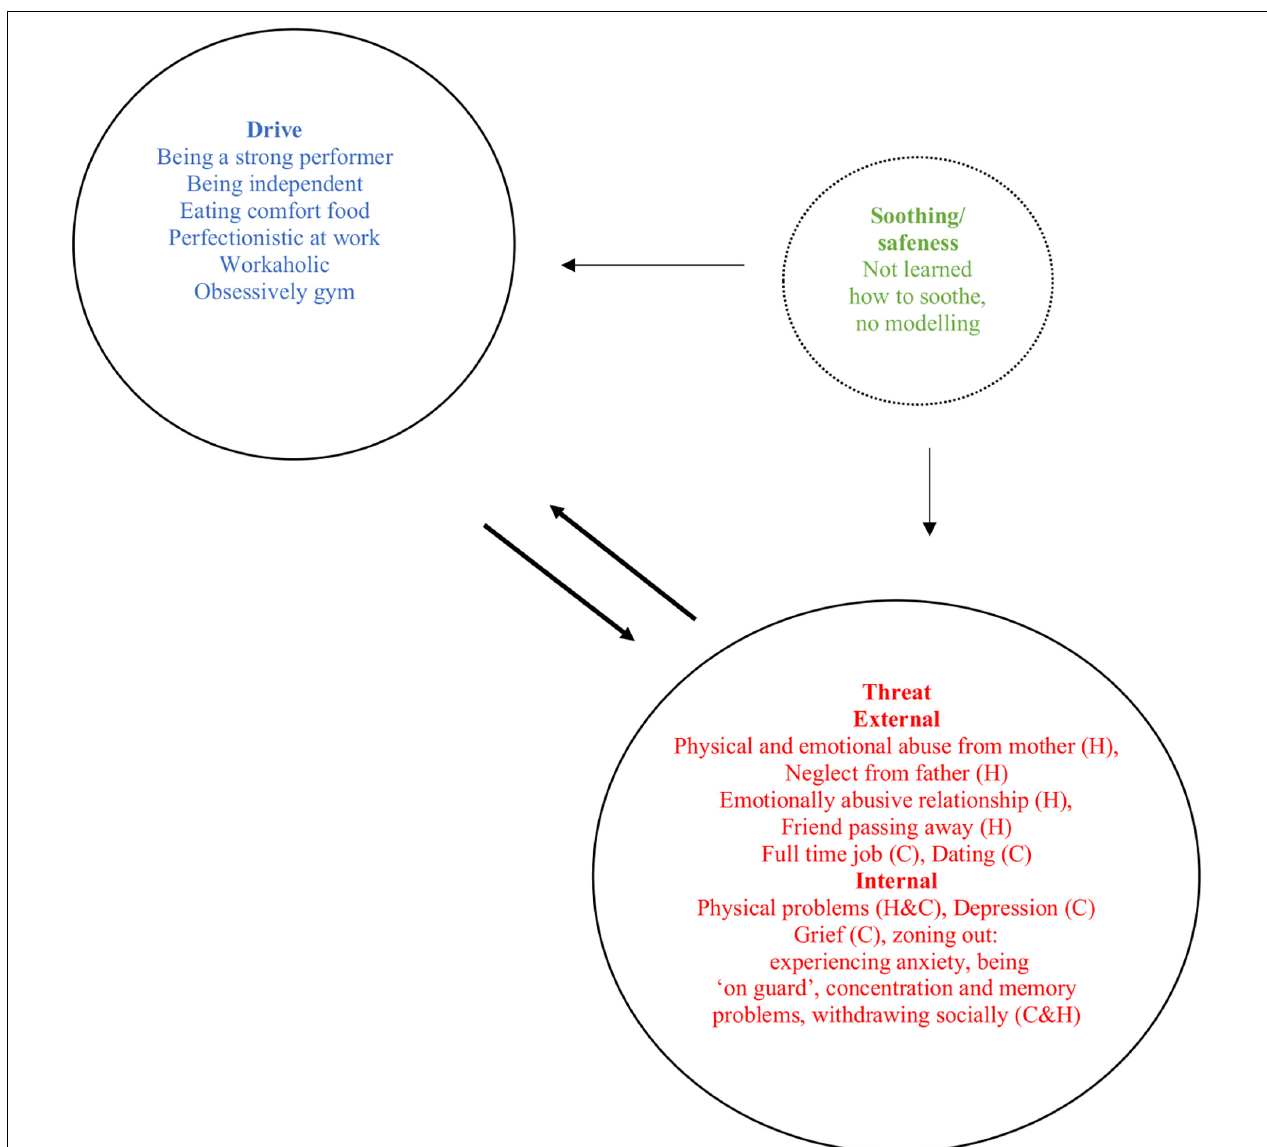
FIGURE 2 | Example of CFT emotion regulation systems case conceptualization [based on Welford (2010)]. H, history; C,